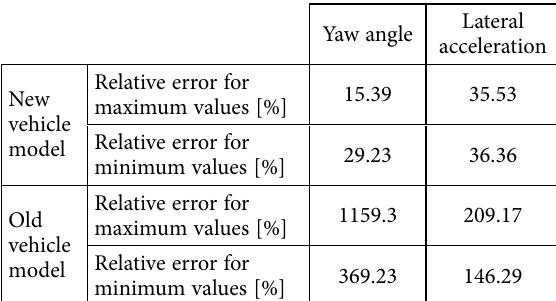
Table 1. Relative errors for max and min values for yaw angle and lateral acceleration –